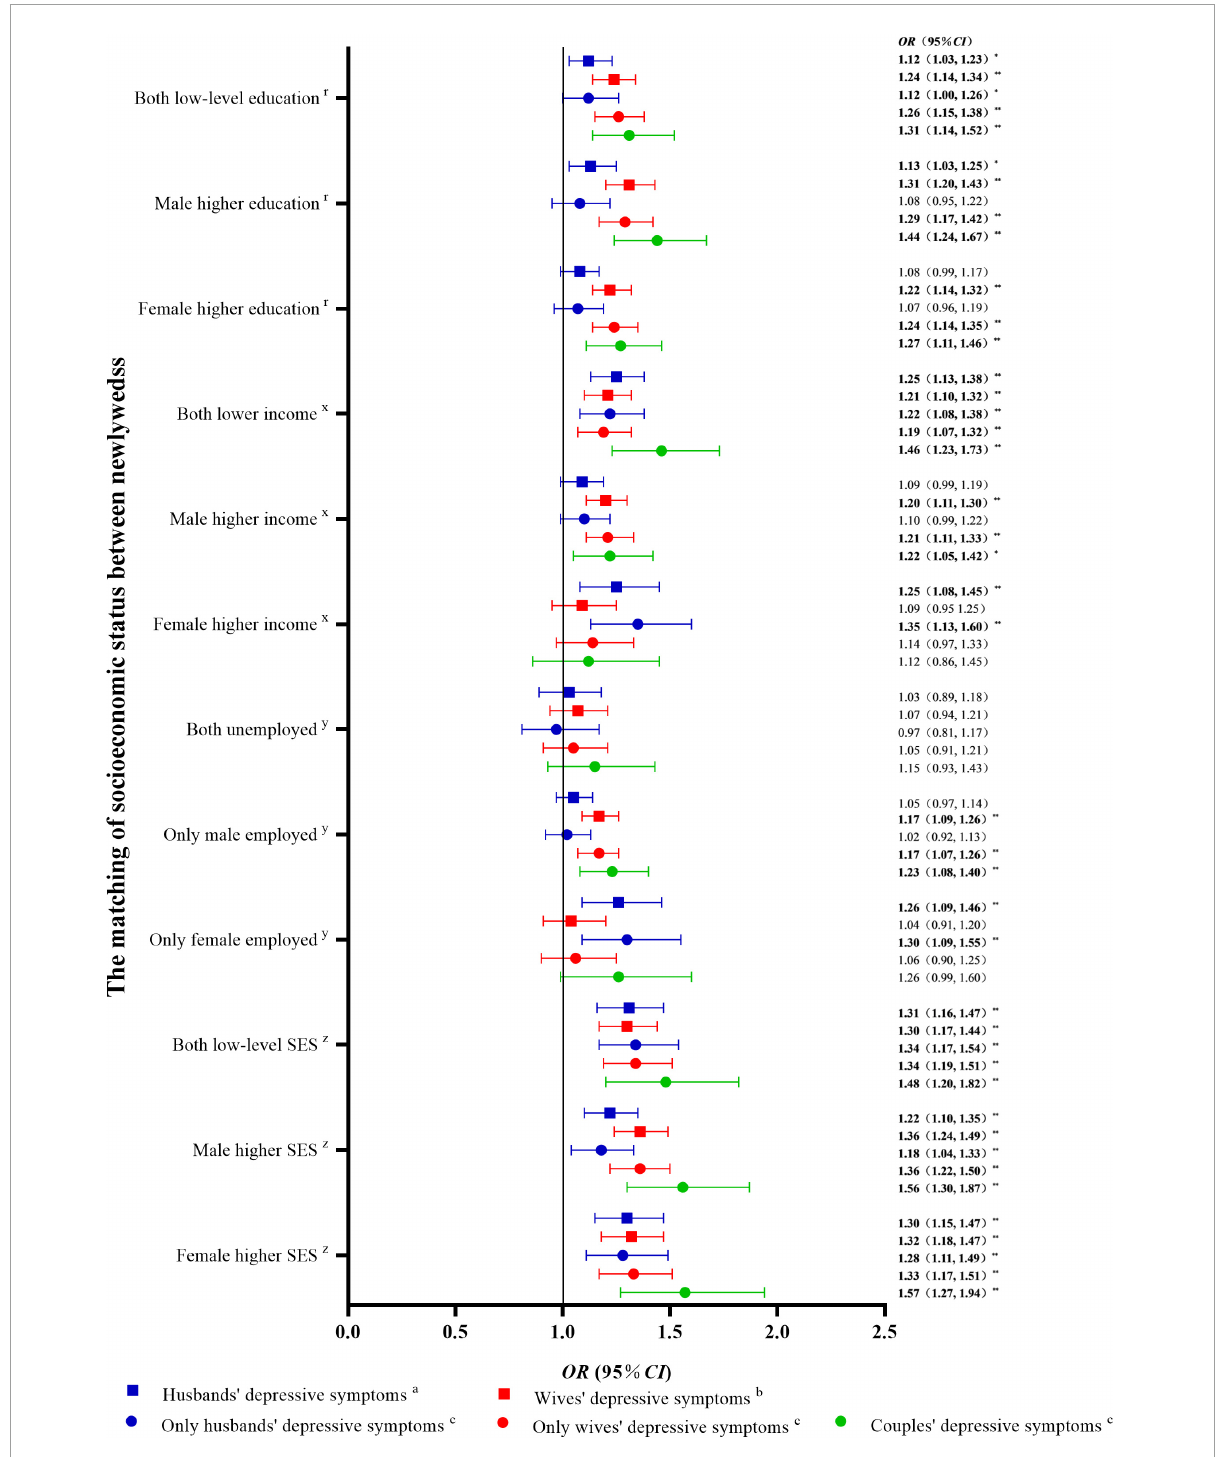
FIGURE5 Multivariable logistic regression between socioeconomic status matching and depressive symptoms in newlyweds. OR, odds ratio; CI, confidence interval; SES, socioeconomic status. a Adjusted for male age, male body mass index (BMI), region, current pregnancy, and male physical activity. b Adjusted for female age, female BMI, region, current pregnancy, and female physical activity. c Adjusted for male age, male BMI, region, male physical activity, female age, female BMI, current pregnancy, and female physical activity. ∗∗ P < 0.01: ∗ P < 0.05. r compared with newlyweds with both high-level education. x compared with newlyweds with both high-level incomes. y compared with newlyweds with both employed. z compared with newlyweds with both high-level